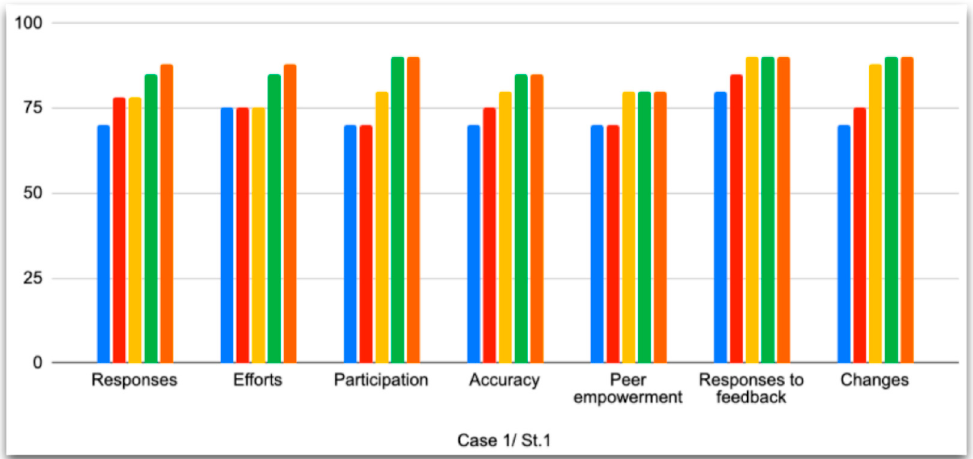
Figure 1. Vocabulary and spelling progress during alternative assessment online/Case 1.